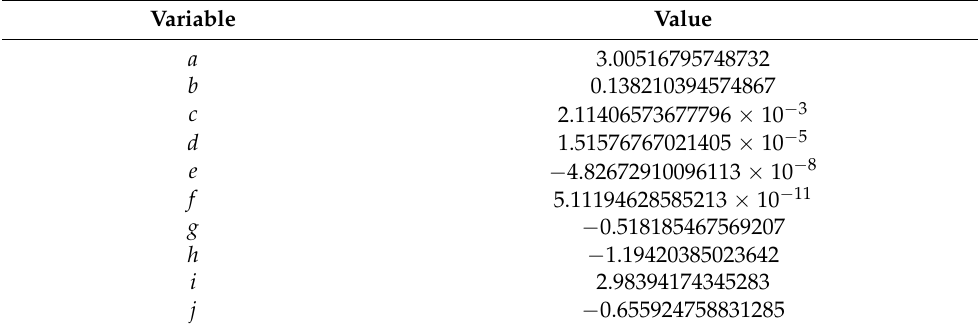
Table 10. Constant values of Equation (2) for the condition of best fit (R 2 = 0.93)—AZ31BF dam- age map.